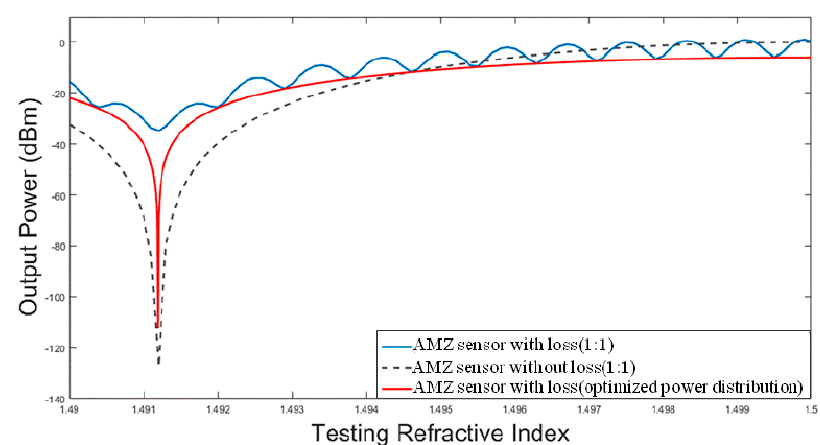
Figure 11. The output power of AMZ sensor with an optimized Y-splitter power (with loss of 2.5 dB/cm, Δ L = 946.1 µm).